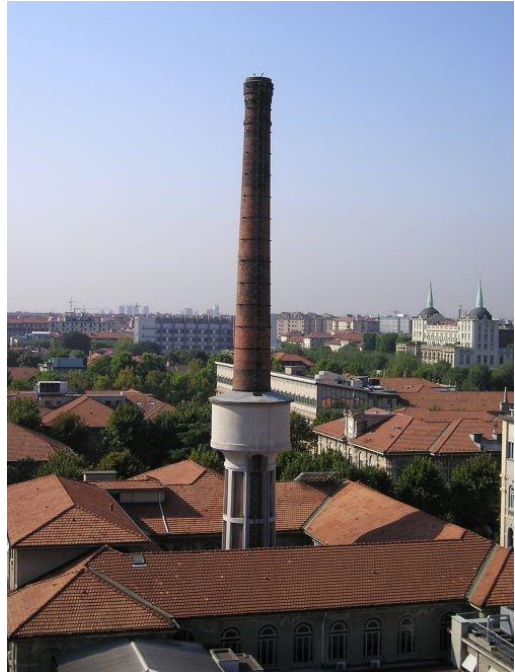
Figure 6. An image of the chimney in Leonardo Campus